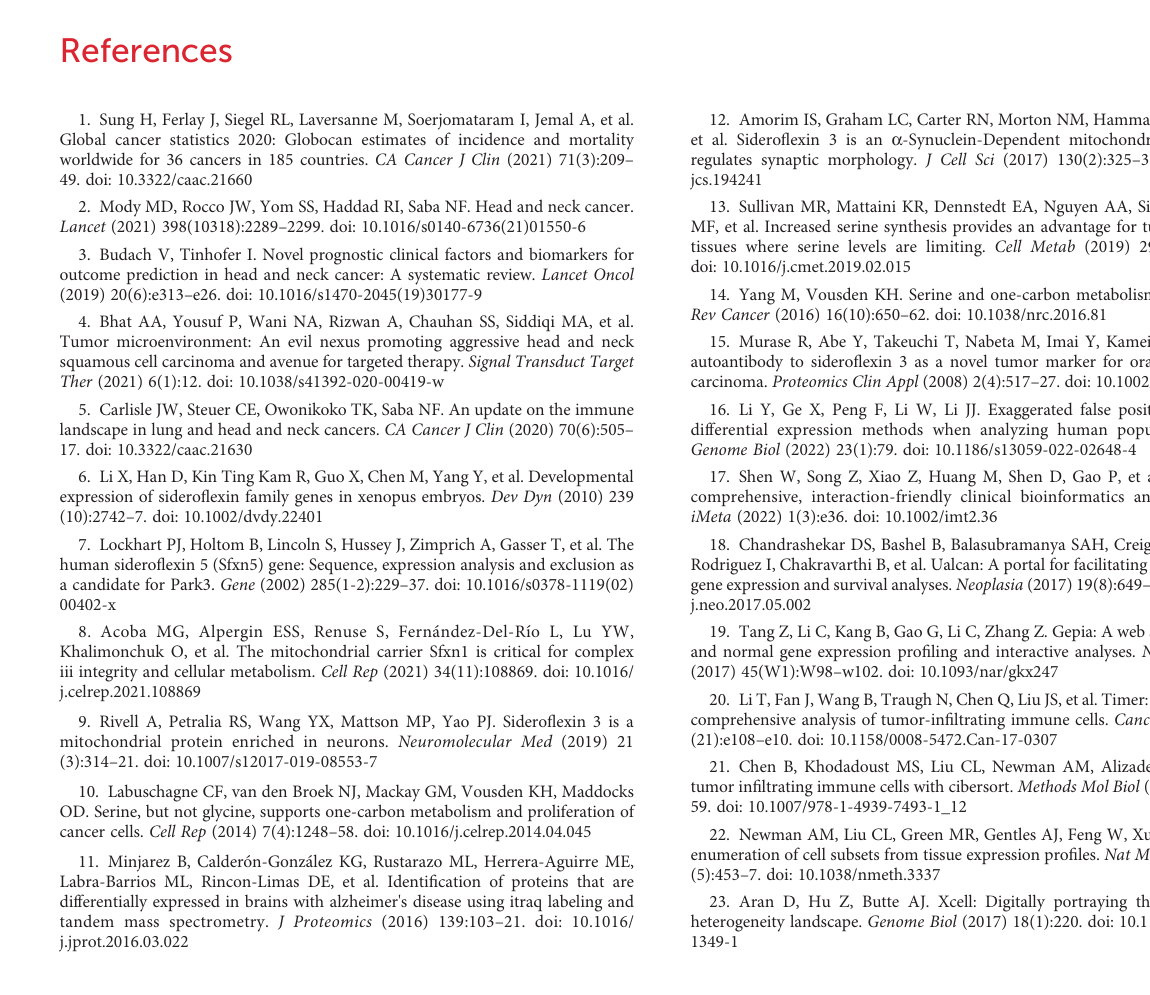
SUPPLEMENTARY TABLE 2 Predicted miRNAs by eight prediction